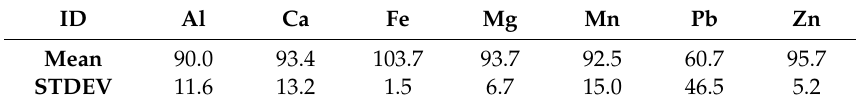
Table 4. Percentage reduction of PTEs from 50 / 50 stabilised moulds compared to raw Sinter ESP dust.